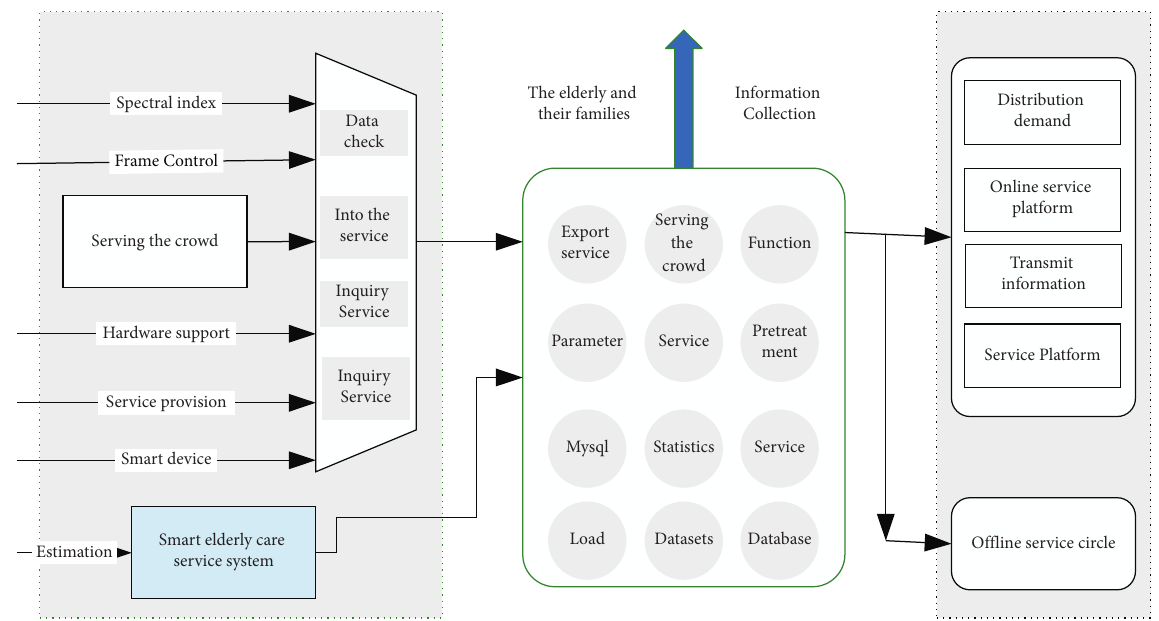
Figure 3: Closed-loop diagram of the smart aging